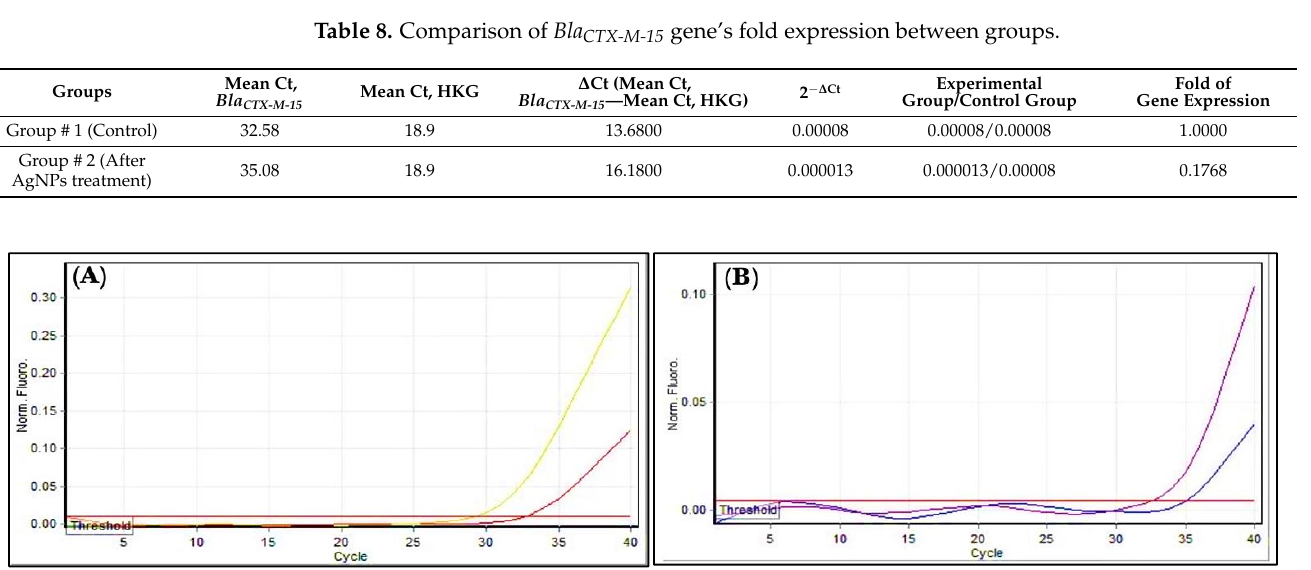
Table 8. Comparison of Bla CTX-M-15 gene’s fold expression between groups.